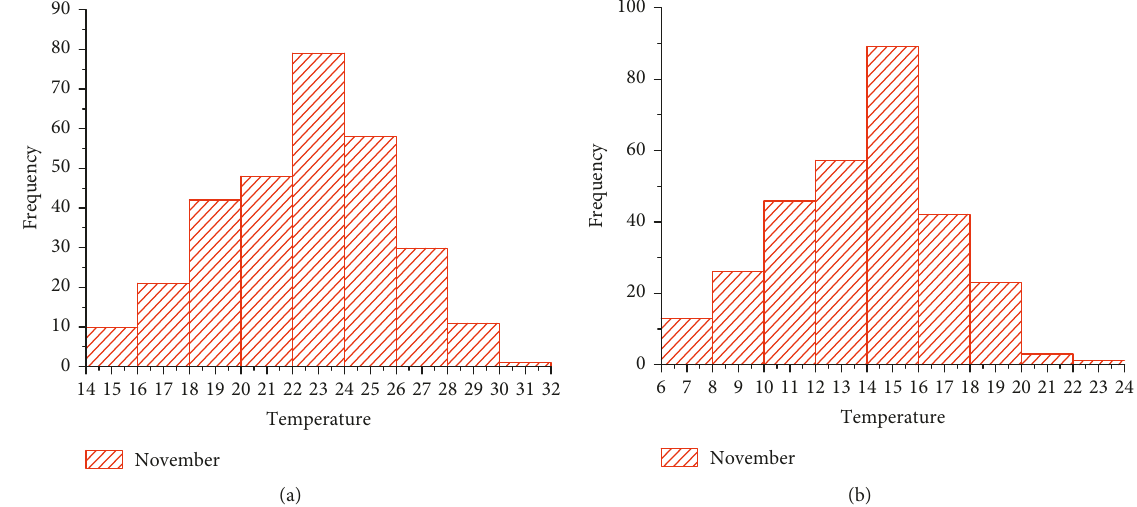
Figure 5: The histogram of the daily extreme value of axial uniform temperature in November. (a) The maximum. (b) The minimum.